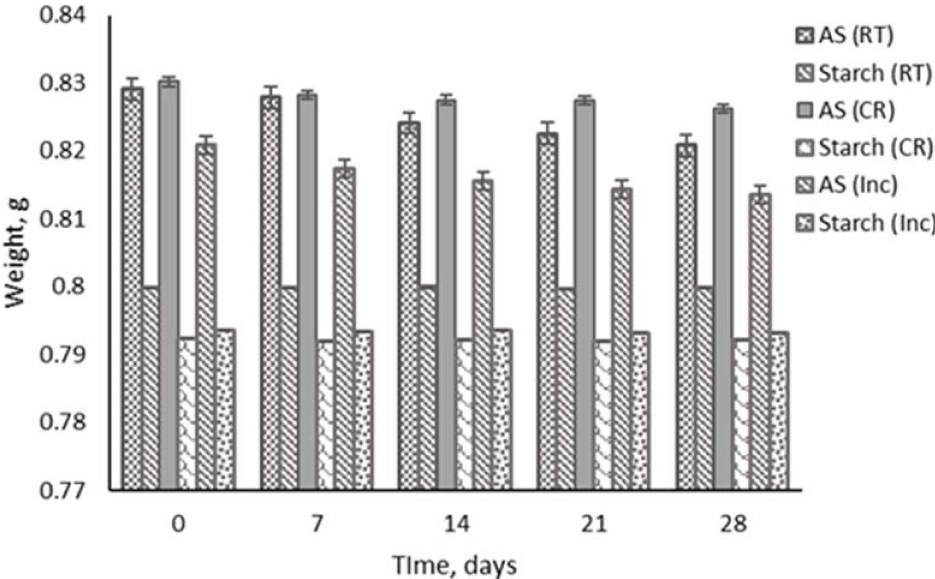
Figure 6. Storage stability of indicator and starch films at room temperature, in a cold room, and in an incubator for 28